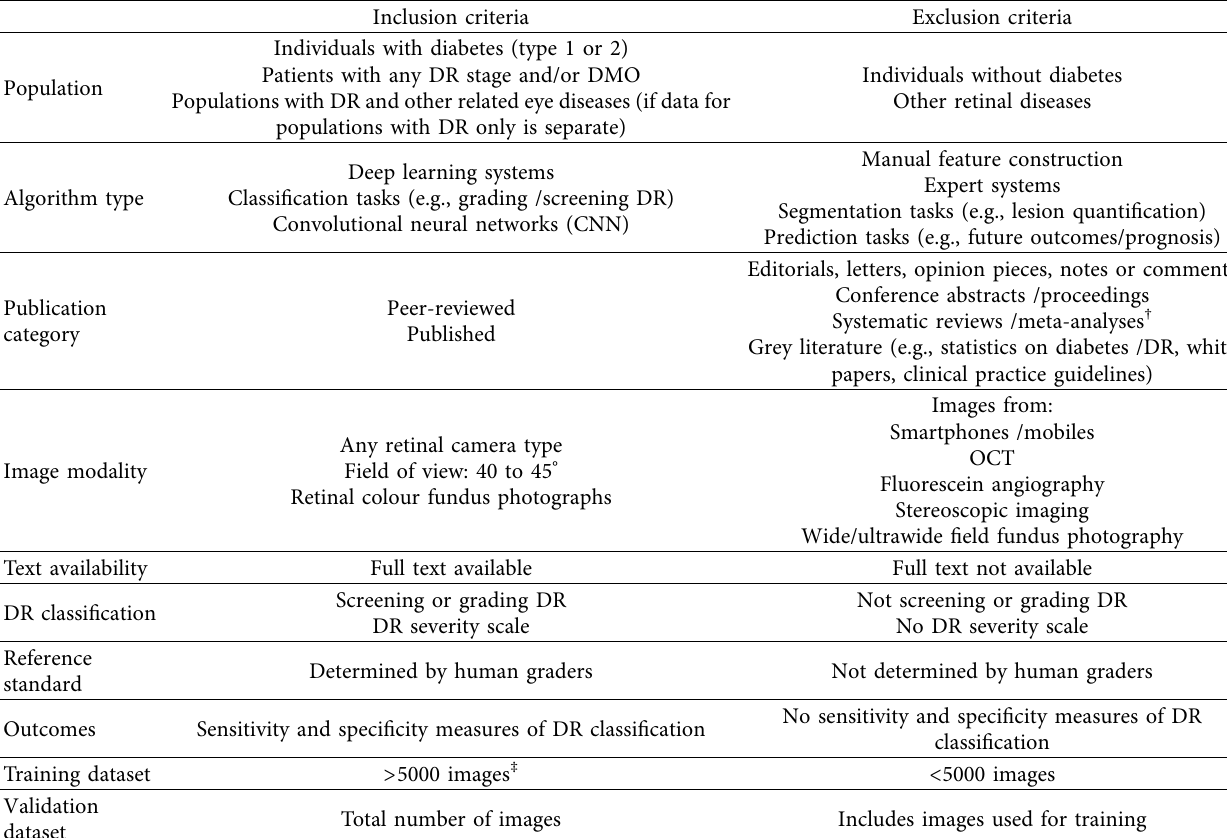
Table 1: Study selection criteria. Stage 1 included population, algorithm type, publication category, and image modality and was applied to 747 articles. The full selection criteria were used for the remaining 65 articles, resulting in the final selection of 13 articles. † These were only used as additional search resources. ‡ This number was arbitrarily